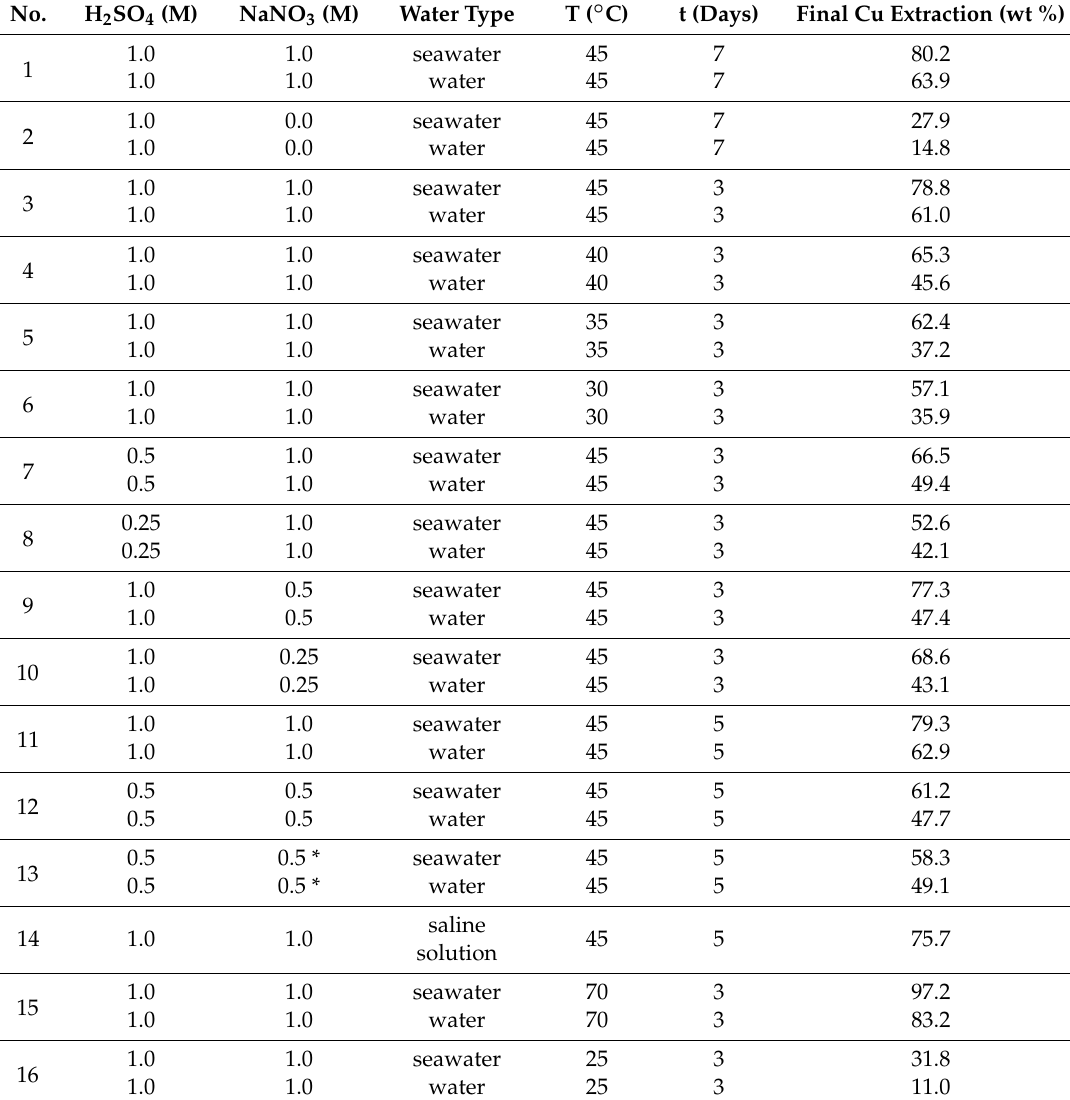
Table 3. Experimental conditions used in chalcopyrite leaching